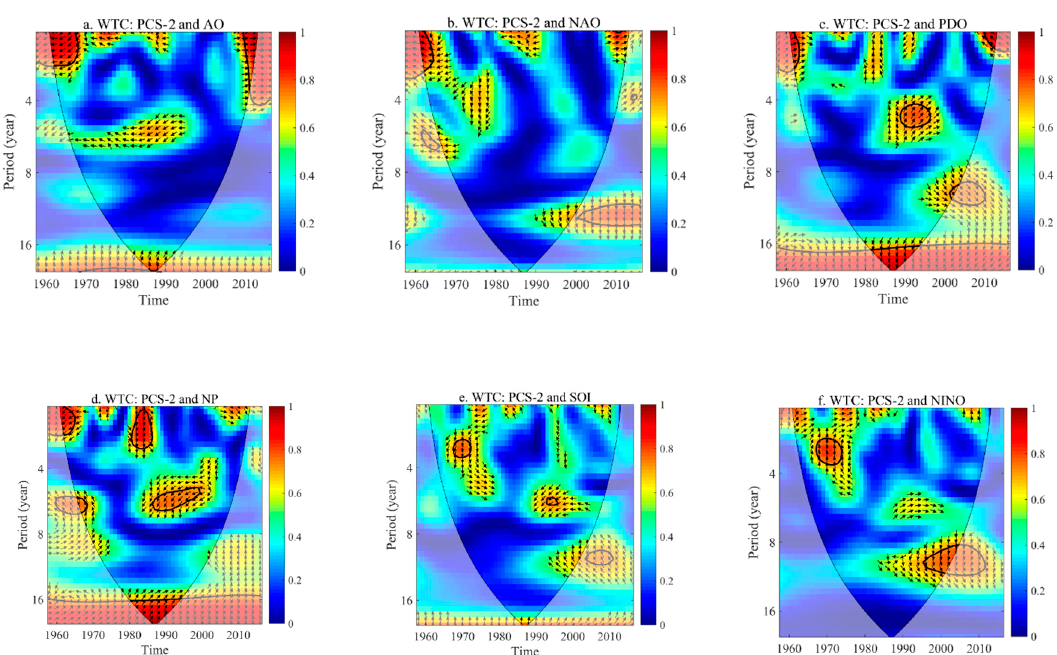
Figure 8. Wavelet coherence spectrum between PCS-2 and climate oscillations ( a – f climate oscillations of AO, NAO, PDO, NP, SOI and NINO, respectively).